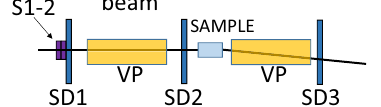
Fig. 8 Experimentalsetup.S1-2aretheplasticscintillatorsusedforthe trigger to select charged particles; SD1, SD2, and SD3 are the Silicon Detectors forming the tracker. The solid line represents the deflected beam. For the measurements with the Si crystal bent along the (cid:2) 110 (cid:3) axis, the SD2, the sample, and the SD3 were placed at 5168 mm, 5821 mm and 11521 mm from the SD1 detector, respectively. For the Si crystal bent along the (cid:2) 111 (cid:3) axis, SD2 was placed at 5207 mm, the crystal at 5567 mm and the SD3 at 11497 mm from the SD1. Between SD1andSD2andbetweenthecrystalandSD3vacuumpipes(VP)were placed to minimize the multiple scattering